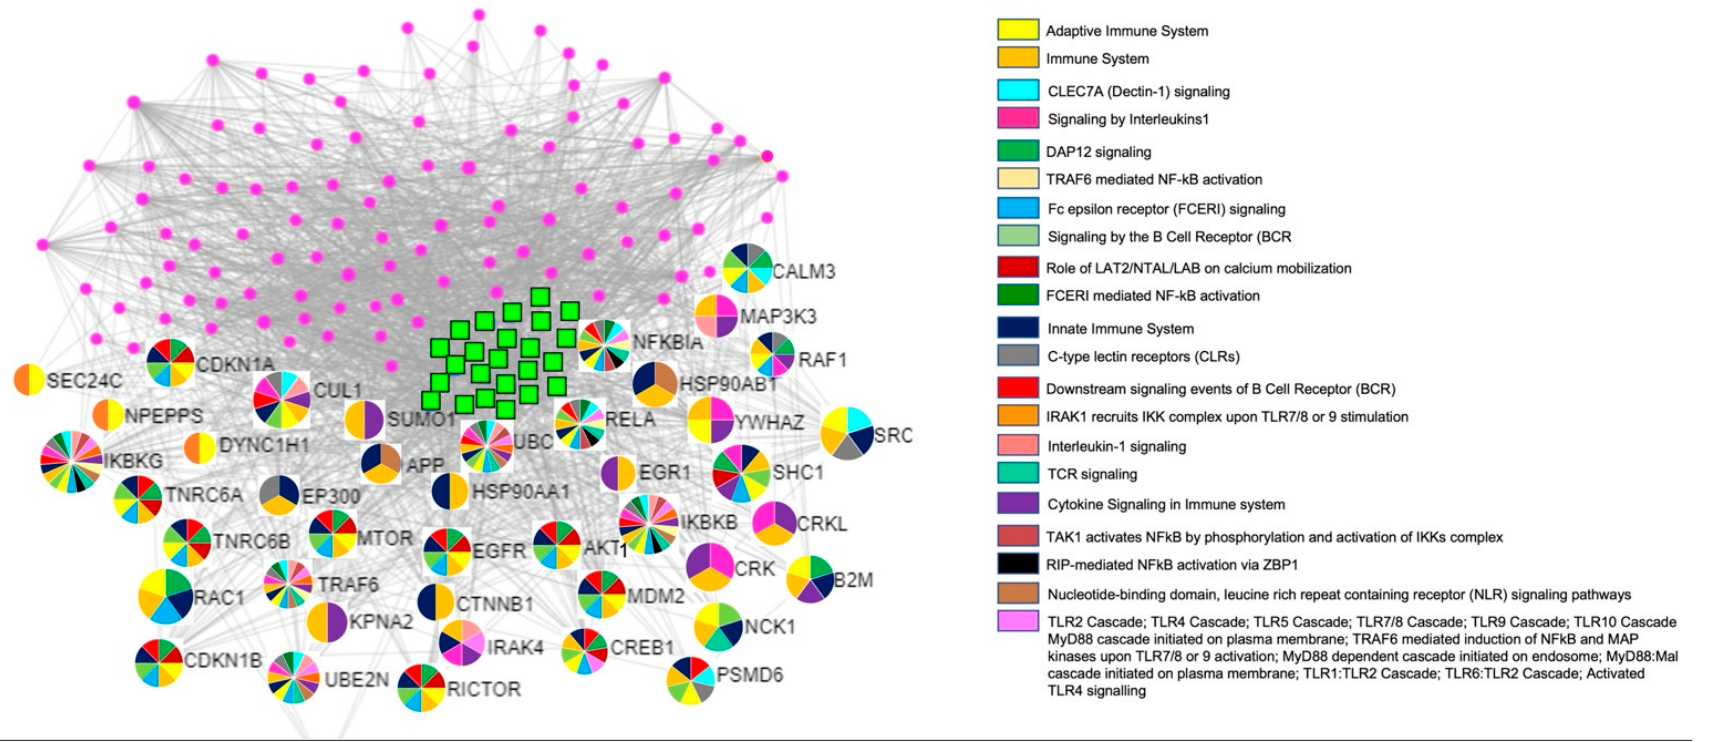
Figure 2. Main genes involved in immune pathways. The green squares represent the 24 deregulated miRNAs; each miRNA target gene is represented with a multicolored circle, based on the specific immune pathways in which it is involved. Pink dots represent other target genes not involved in immune pathways.